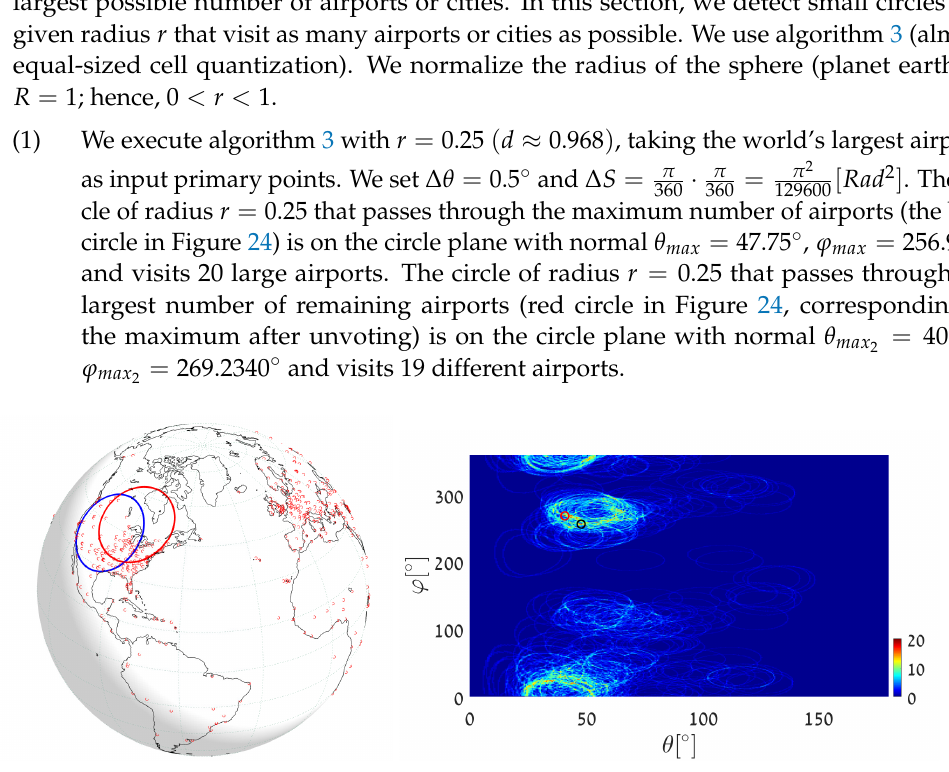
Figure 24. Executing Algorithm 3 with r = 0.25 on the airport database. ( Left ) The blue circle passes through the maximum number of airports (red dots). The red circle corresponds to the second maximum, following the unvoting process. ( Right ) Heat plot of the accumulator array M , showing the parameters of the two